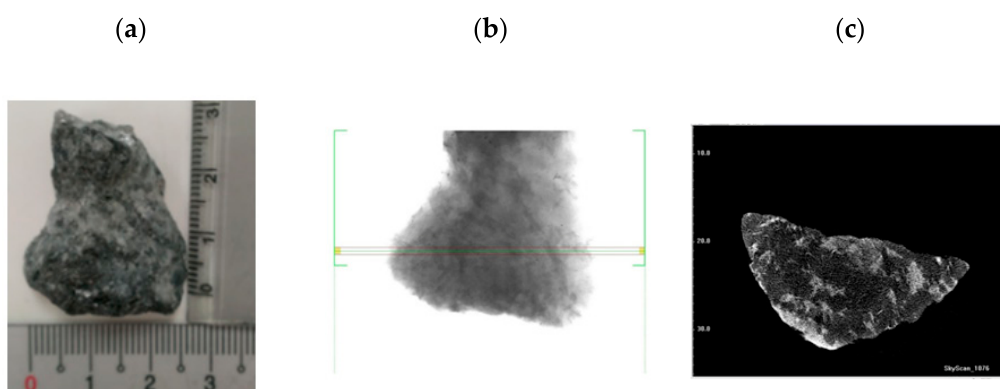
Table 1. The ADE experimental conditions in this Figure 2. Micro-CT images of granite. ( a ) Intact granite sample, ( b ) horizontal scanning images in CT, and ( c ) vertical images in a tested granite sample.